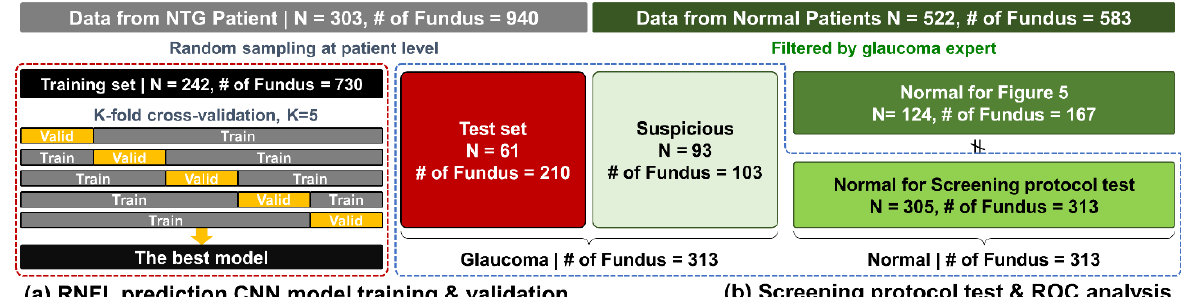
Figure 2. Summary of research workflow. ( a ) Data acquired from NTG patients were utilized for model training and evaluation. ( b ) Screening test and ROC analysis performed with test set plus data from normal patients.